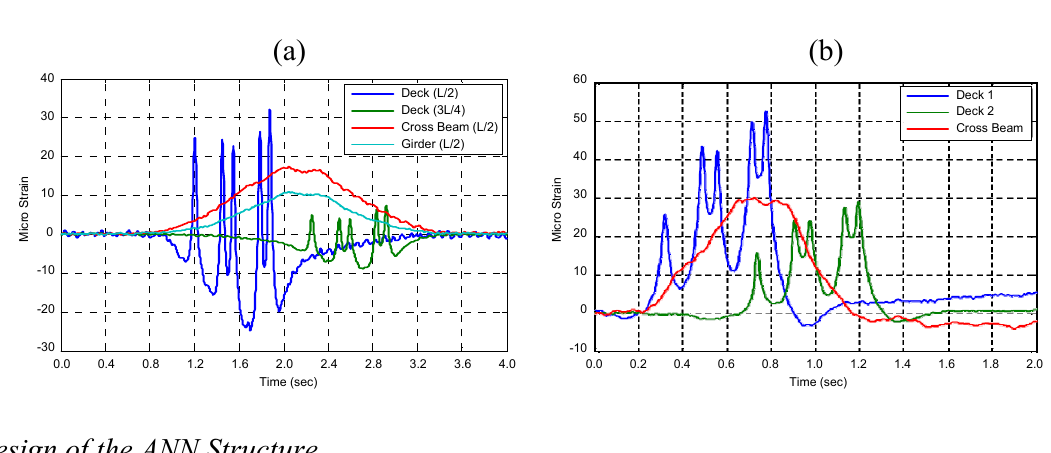
Figure 6. Representative B-WIM signals of (a) Geumdang Bridge. (b) Seohae